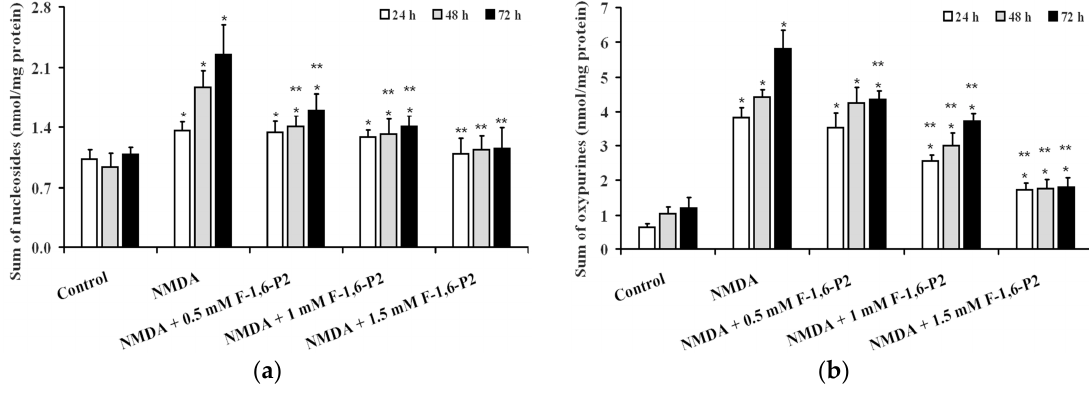
Figure 5. Effects of F-1,6-P2 on the imbalance of adenine nucleotide catabolism in NMDA-treated OHSC. OHSC were challenged with 30 µ M NMDA for 3 h and then incubated without and with increasing concentrations of F-1,6-P2 (0.5, 1 and 1.5 mM) for different times (24, 48 and 72 h). Control OHSC were incubated for the same time intervals, with no prior NMDA treatment or F-1,6-P2 addition. Sum of nucleosides ( a ) = adenosine + inosine + guanosine. Sum of oxypurines ( b ) = hypoxanthine + xanthine + uric acid. Nucleosides and oxypurines were determined by HPLC in deproteinized cell extracts. Histograms are the mean of 6 different OHSC preparations. Standard deviations are represented by vertical bars. * Significantly different from corresponding time of control OHSC, p < 0.001. ** Significantly different from corresponding time of NMDA-challenged OHSC with no F-1,6-P2 supplementation, p < 0.001.